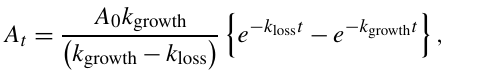
Figure 6. Bimolecular plots of the pseudo-first-order rate coeffi- cients, k (cid:48) , determined from fits of Eq. (2), to observed CH 2 OO decays as a function of [SO 2 ] at total pressures of 20Torr (blue points and line; giving k 5 (3.73 ± 0.19) × 10 − 11 cm 3 s − 1 , intercept = (500 ± 600s − 1 ) ), 50Torr (green points and line; giving k (3.84 ± 0.27) × 10 − 11 cm 3 s − 1 , intercept = (700 ± 900s − 1 )), and 100Torr (orange points and line; giving k 5 = (3.95 ± 0.28) × 10 − 11 cm 3 s − 1 , intercept = (100 ± 900s − 1 )). The data compare well to the current IUPAC recommendation of × 10 − 11 cm 3 s − 1 (Cox et al., 2020). For these data T = 298K, and initial CH 2 I 2 concentrations were in the range 2.1– 9.5 × 10 14 cm − 3 . Error bars are 1 σ from the fits to Eq. (2). The in- set plot shows typical plots obtained for 250 photolysis shots at p = 50Torr with the fits to Eq. (2) (for the data shown in black, [SO 2 ] = 1.4 × 10 14 cm − 3 , and k (cid:48) = (5860 ± 90)s − 1 ; for the data shown in blue, [SO 2 ] = 2.2 × 10 14 cm − 3 , and k (cid:48) = (9860 ± 280)s − 1 ; and for the data shown in green, [SO 2 ] = 5.4 × 10 14 cm − 3 , and k (cid:48) = (19920 ± 440)s − 1